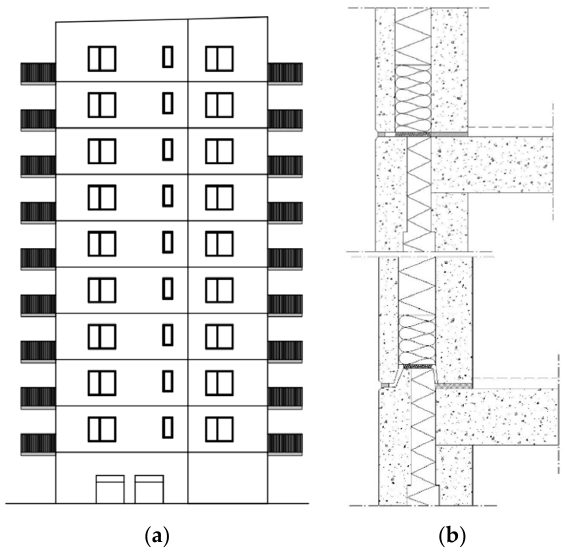
Figure 2. Suggested technical solution: ( a ) typical precast concrete facade; ( b ) example of the application in two different horizontal joints of precast concrete sandwich panels. Table 1. Stakeholders identified as of interest to be involved (based on the analysis of stakeholders).